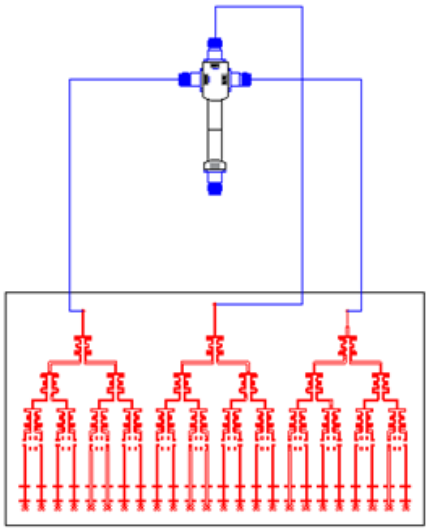
Figure 5. Structure diagram of the feed network of the antenna array.